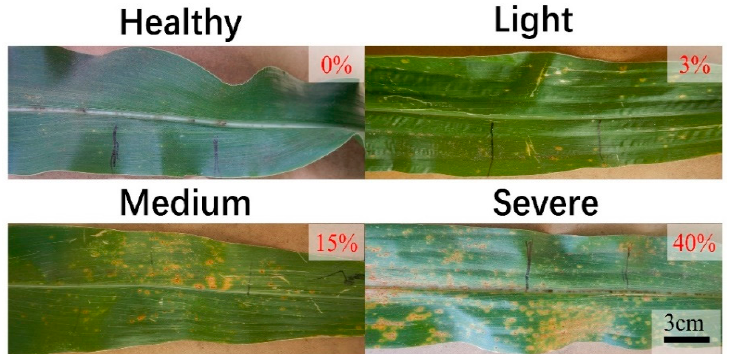
Figure 3. Healthy corn leaf and Southern Corn Rust (SCR)-infected corn leaves with different infection severities. The numbers on the upper-right side showed the visual estimations of percentage of lesion areas on leaves.